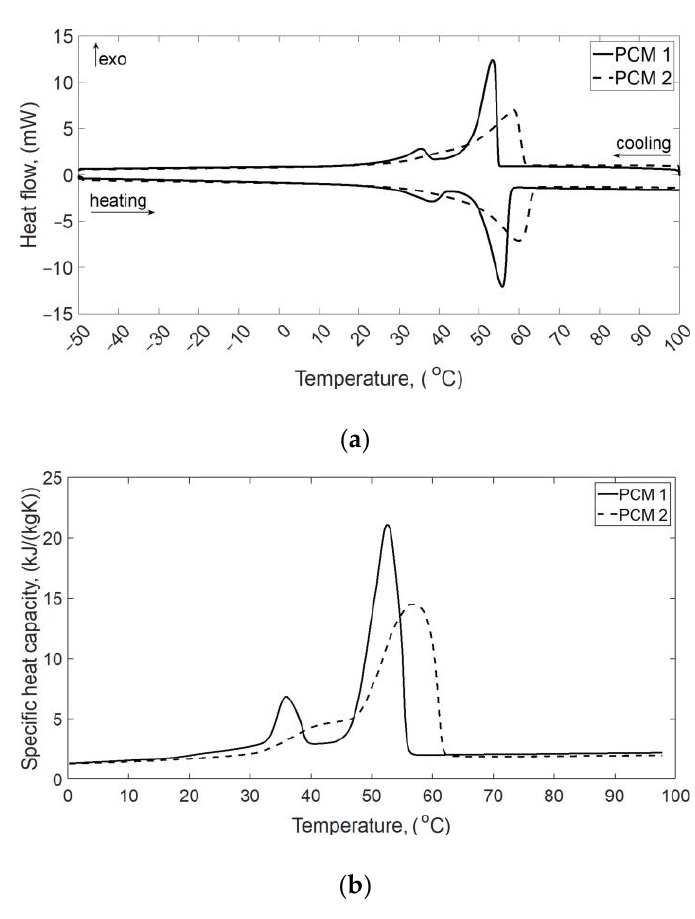
Figure 5. ( a ) DSC curves; ( b ) specific heat capacity of the PCMs. Table 5. Thermal properties of the investigated PCMs.